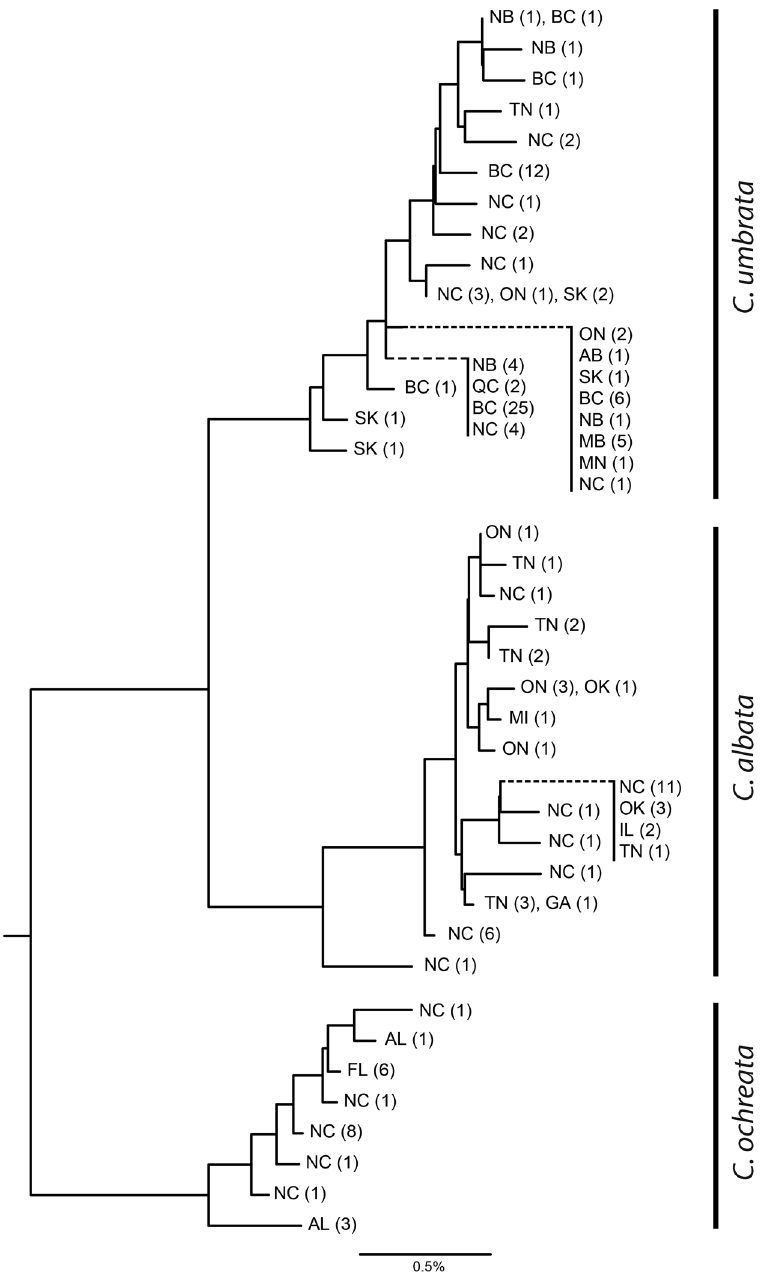
Figure 23. Neighbour-joining tree of representative mtDNA barcode haplotypes in North American Clemensia species. Sample size and locality are given in brackets, with number of specimens indicated after two-letter state/province abbreviation. Lacinipolia sareta variation is divided into five haplogroups, A–E. Voucher specimen data is given in Suppl. material